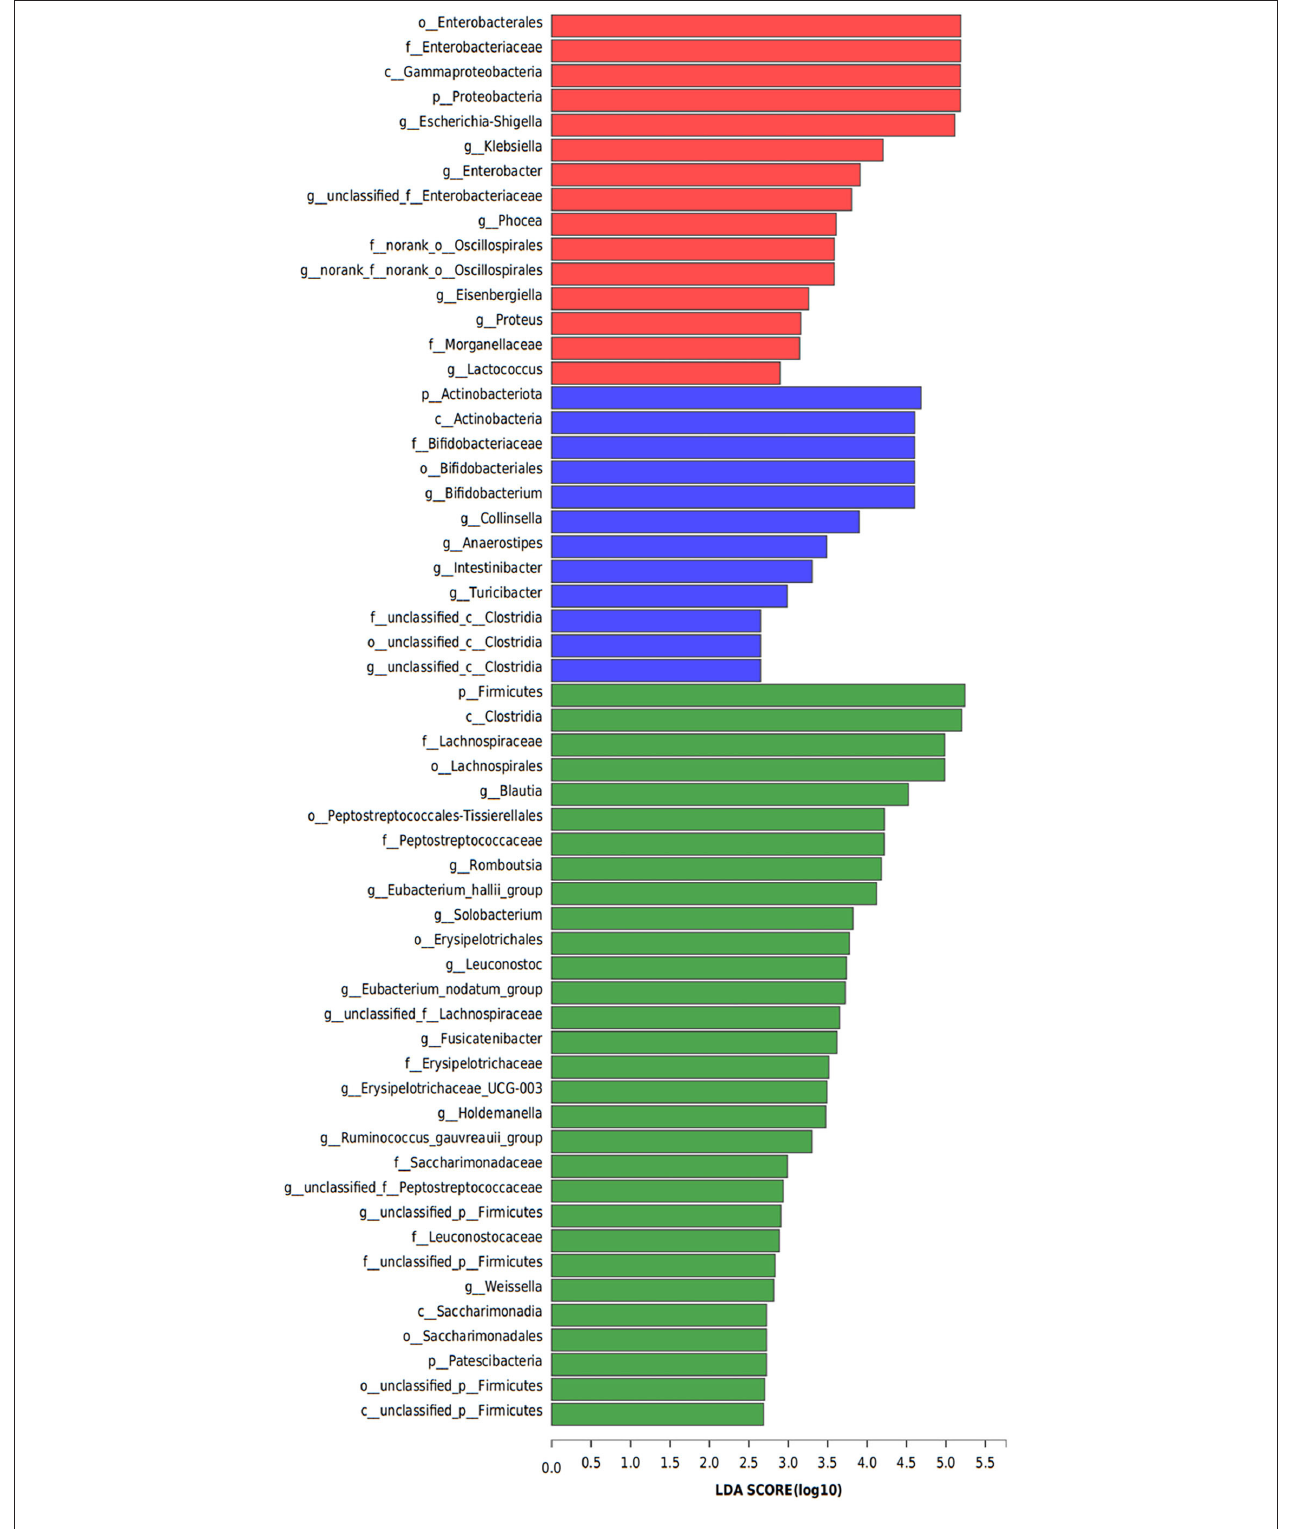
FIGURE 7 | Metagenome biomarkers of bacterial flora. Analysis of metagenome biomarkers with linear discriminant analysis of effect sizes (LEfSe). Important taxonomic differences in the fecal microbiomes were identified among the three groups (LDA > 2, non-parametric factorial Kruskal–Wallis rank-sum test, p < 0.05).